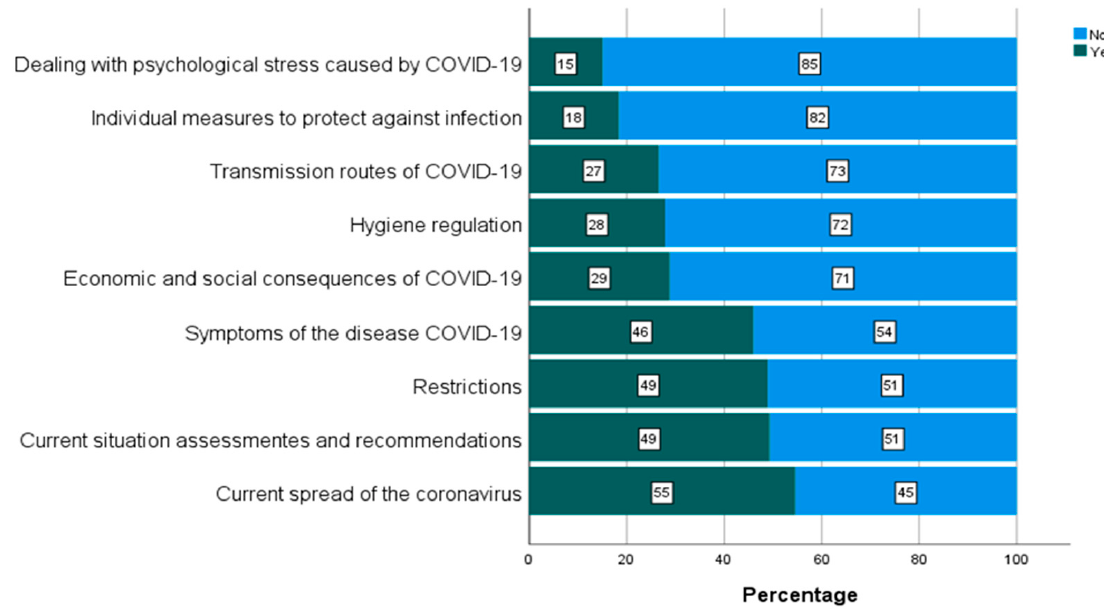
Figure 3. Internet search queries related to COVID-19 (n = 1518).